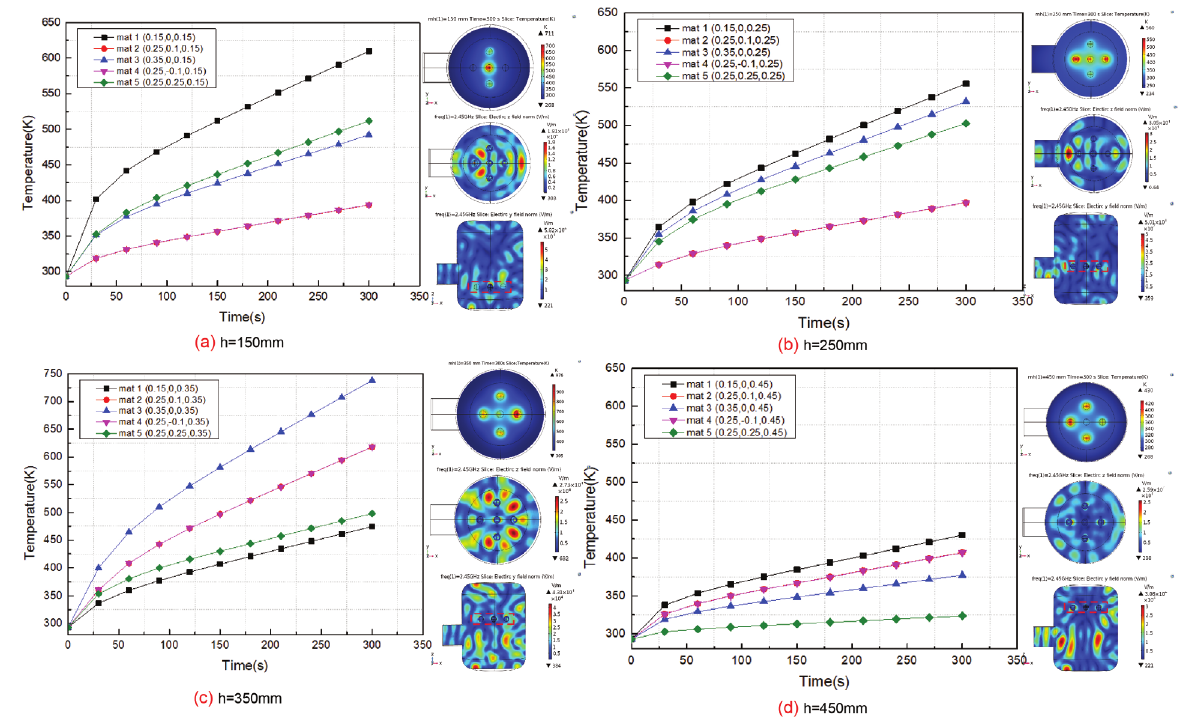
Figure 4: Influence of the variations of height on the heating rate and temperature distribution, combination A.